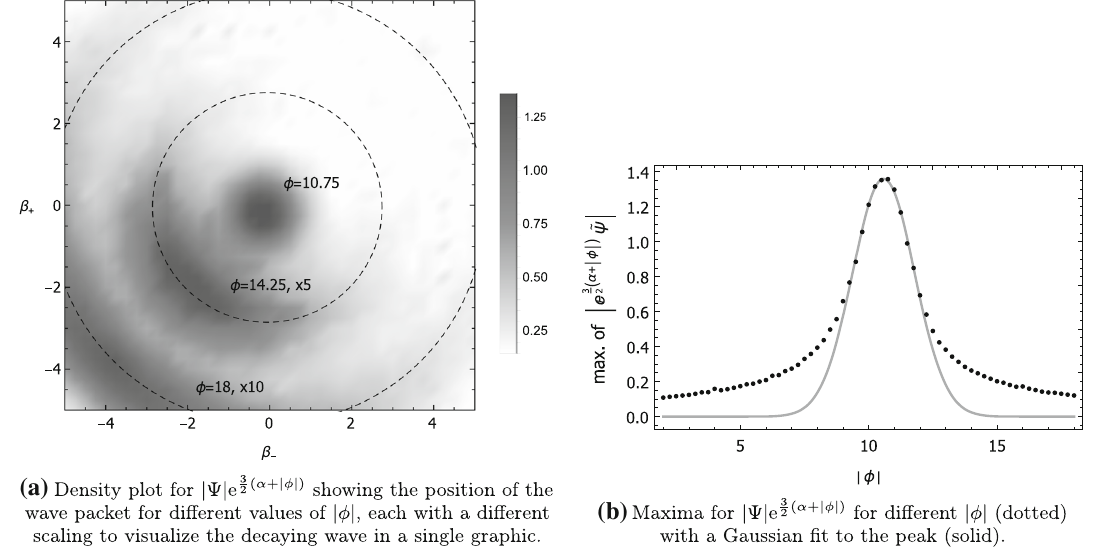
Fig. 5 Numerical results for the wave packet | (cid:2) | e 3 2 (α +| φ | ) using the asymptotic WKB form of (42) and α = 10, V 0 = ¯ p + = ¯ p − = ¯ p 3 = 1, (cid:20) p = 1 .